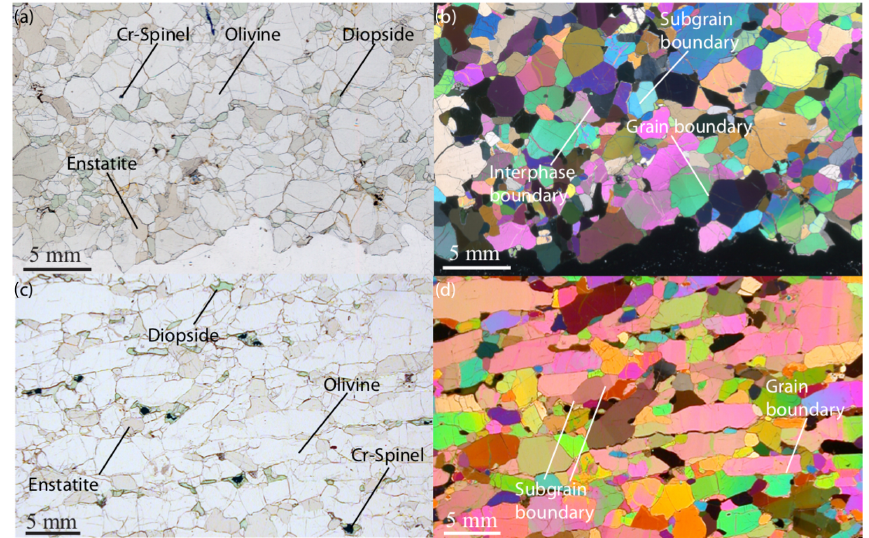
Figure 10. Natural mantle specimens. (a) Polarized and (b) cross-polarized light microphotographs of a coarse-grained microstructure in a spinel-bearing peridotite from Tariat, central Mongolia (sample Shava SH-11-27 from Demouchy et al., 2019). (c) Natural and (d) cross- polarized light microphotographs of a rare tabular microstructure in a diopside-poor lherzolite with irregularly shaped enstatite from Tok, Siberia (sample 10-16 from Tommasi et al., 2008; images courtesy of Andrea Tommasi): olivines show numerous subgrain boundaries perpendicular to the long axis of the tabular crystals but straight grain boundaries parallel to the rock foliation.